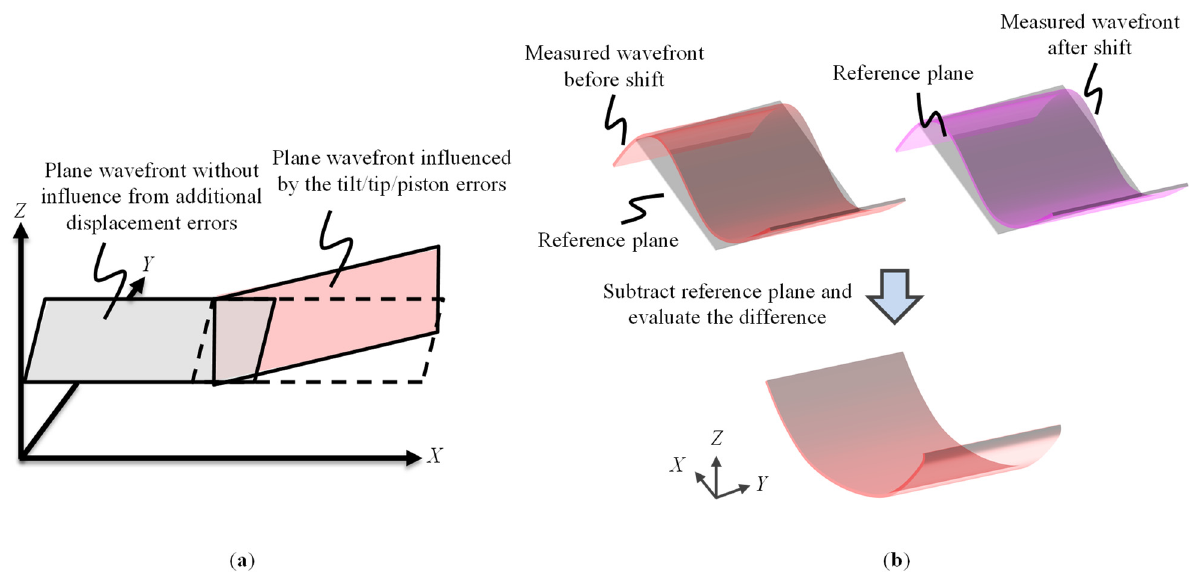
Figure 4. The proposed reference plane technique: ( a ) An example showing the plane wavefront influenced by the tilt/tip/piston error after the shift; ( b ) A schematic showing the procedure of the proposed reference method.